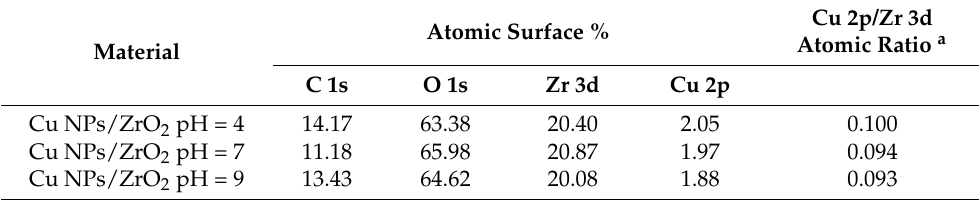
Table 3. Surface atomic percentages as determined by